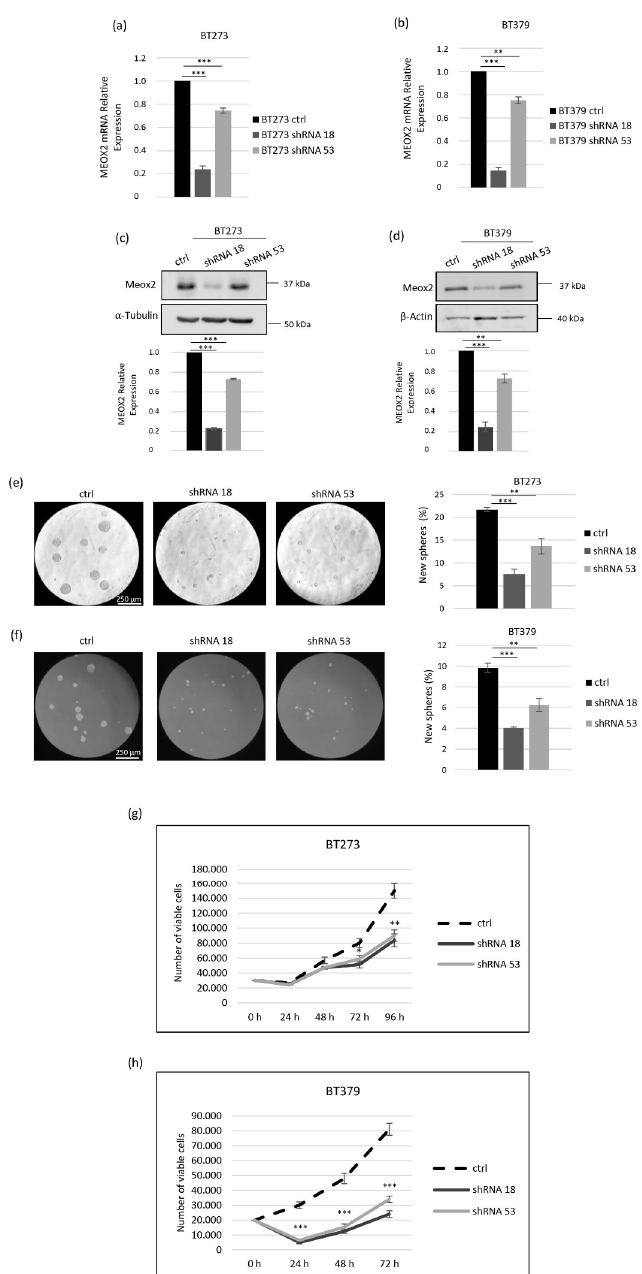
Figure 1. MEOX2 depletion inhibits the sphere-forming and the growth ability of glioblastoma stem cells BT273 and BT379. ( a , b ) MEOX2 qRT-PCR analysis of BT273 ( a ) or BT379 ( b ) cells transduced with shRNA18 or shRNA53 or ctrl lentiviral constructs. The values were reported in relation to cells transduced with ctrl vector set as = 1 and normalized to PPP2CA mRNA expression ( n = 3; mean ± SD). ( c , d ) MEOX2 Western blot analysis of BT273 ( c ) or BT379 ( d ) cells transduced with shRNA18 or shRNA53 or ctrl lentiviral con- structs. For BT273 and BT379, α -tubulin and β -actin were used as the internal loading controls, respectively. Representative images are shown. The bottom histograms show the quantification of MEOX2 in relation to α -tubulin and β -actin. ( n = 3; mean ± SD). ( e , f ) Sphere-forming assay of BT273 ( e ) and BT379 ( f ) cells transduced with shRNA18 or shRNA53 or ctrl lentiviral constructs. Histograms show the percentage of cells capable of re-forming a neurosphere seven days after dissociation ( n = 3; mean ± SD). Representative micrographs are shown. ( g , h ) Growth curves of BT273 ( g ) and BT379 ( h ) cells transduced with shRNA18 or shRNA53 or ctrl lentiviral constructs. ( n = 3; mean ± SD). Differences between two groups were assessed using unpaired Student’s t -test (two-tailed). Significance was defined as * p < 0.05; ** p < 0.01; *** p < 0.001, statistical difference compared to the